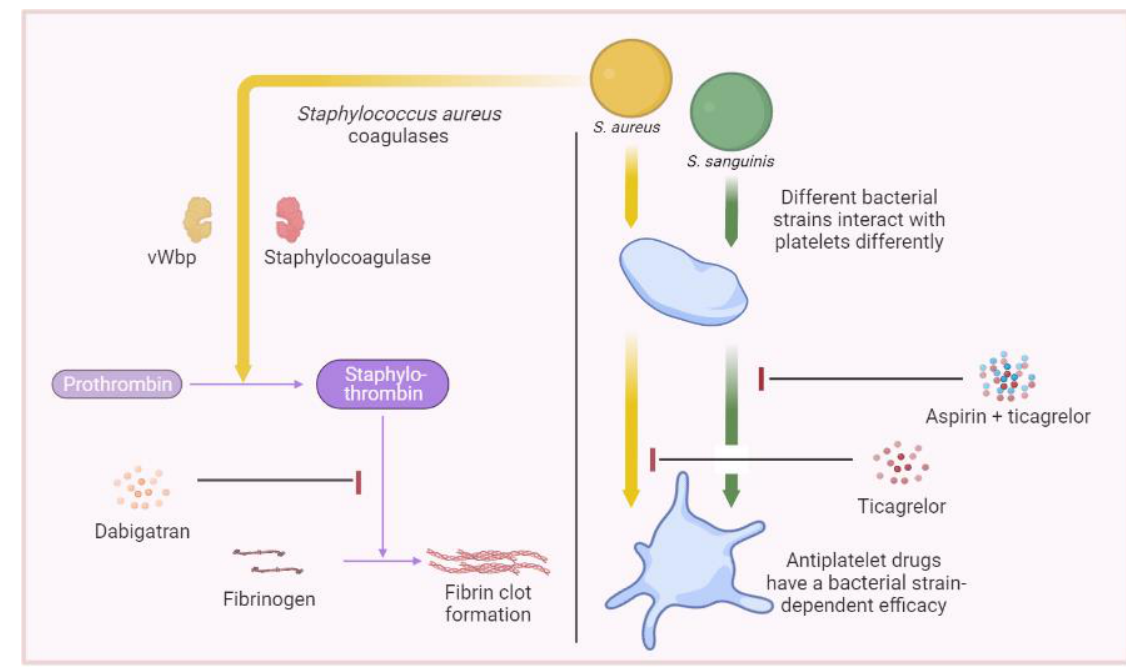
Figure 2. The effect of antithrombotic agents on hemostasis induced by bacteria. Right , the effect of oral antiplatelet agents on platelet aggregation induced by different bacterial strains. Left , the effect of dabigatran on coagulation induced by Staphylococcus aureus coagulases. Illustrations were created using https://www.biorender.com, accessed on 17 March 2023. vWbp: von Willebrand factor-binding protein.